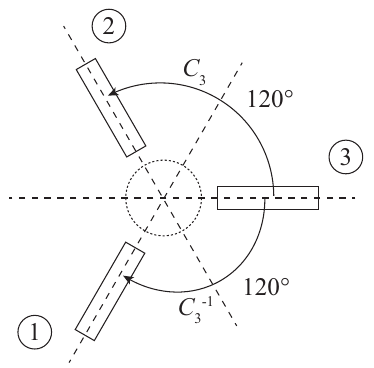
Figure 5. Symmetry elements C 3 and C − 1